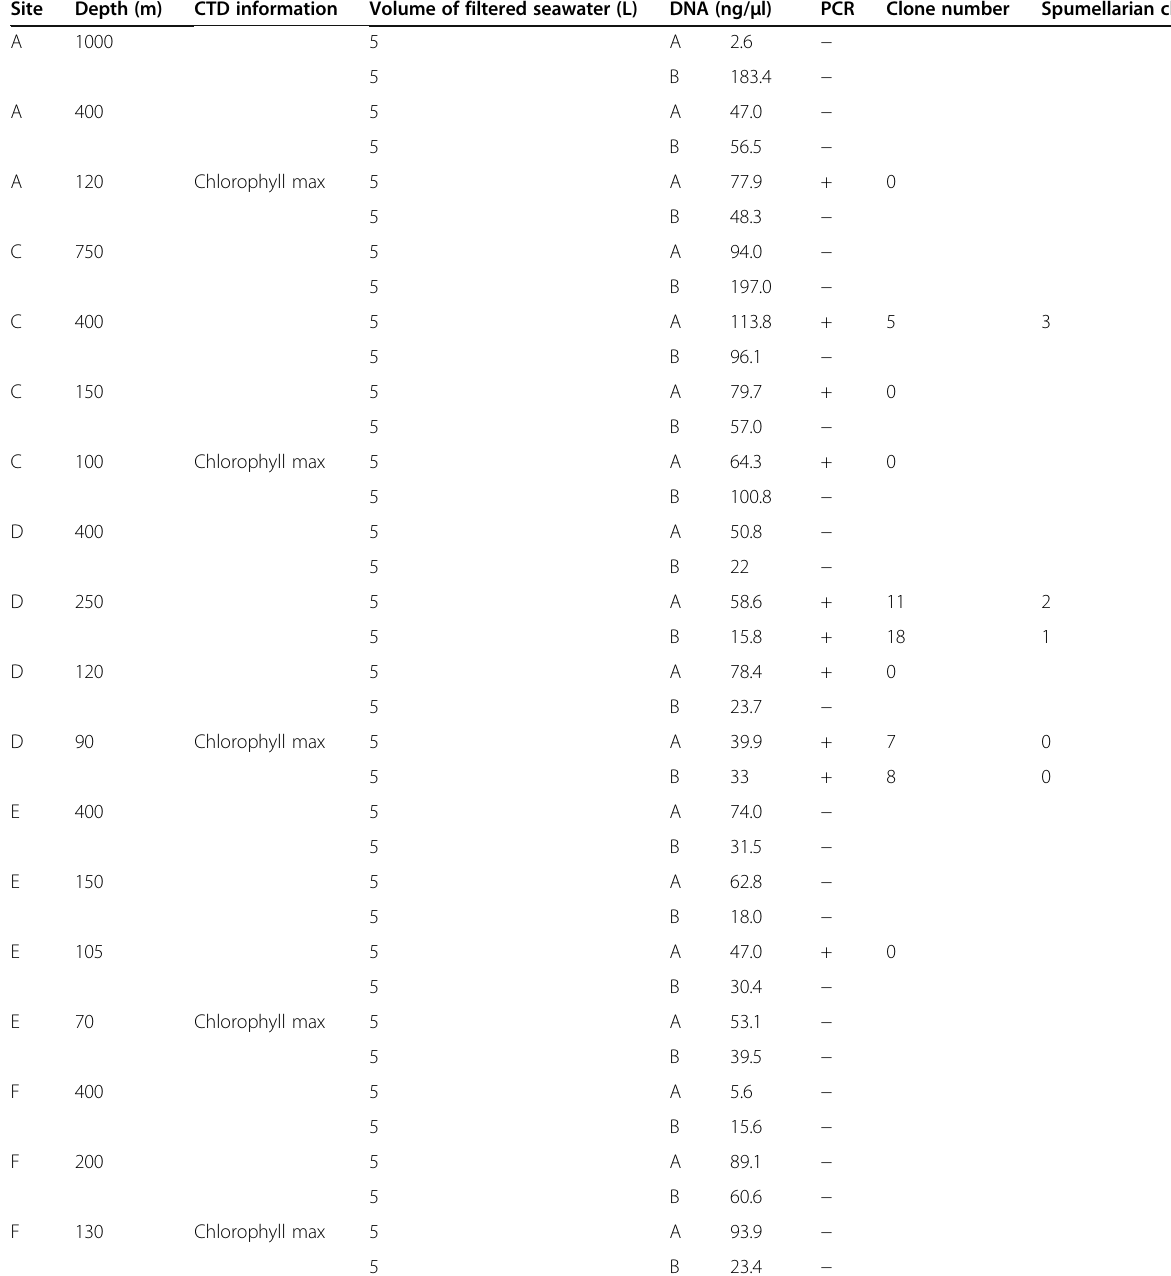
Table 1 Results of molecular cloning for the environmental DNA from five sites Site Depth (m)